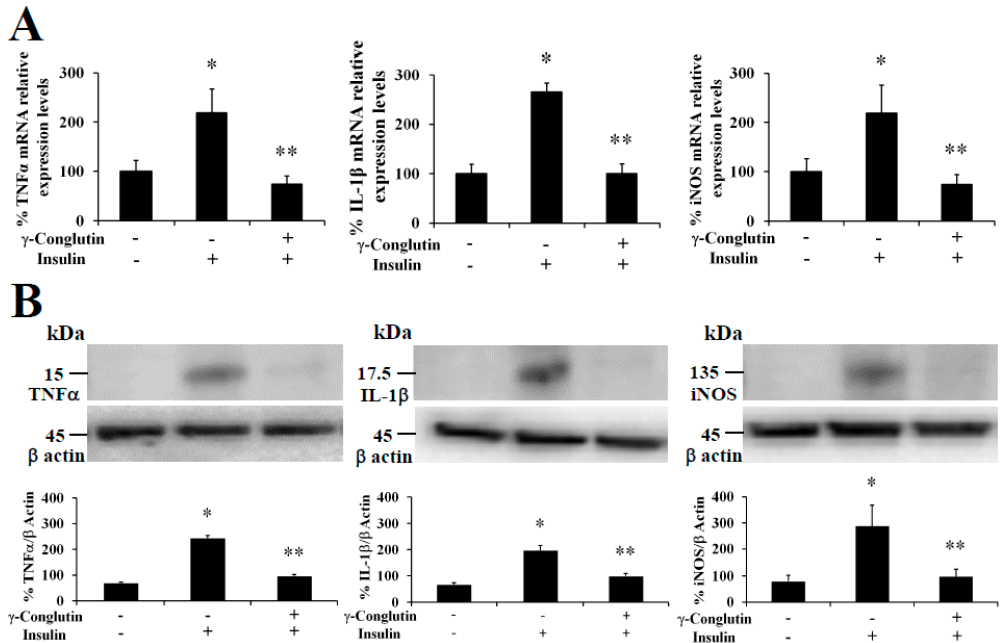
Figure 3. NLL γ -conglutin decreases the mRNA expression and protein levels of TNF α , IL-1 β and iNOS on an insulin-resistance IR-C cell model. Control PANC-1 cells, and IR-C pancreatic cells were cultured for 24 h alone, or the former culture with γ -conglutin. ( A ) The bar graph shows mRNA levels determined by real-time RT-qPCR of TNF α , iNOS and IL1 β . (B) The bar graph shows protein levels determined by immunoblotting of TNF α , iNOS and IL1 β . Average value from triplicate experiments of each biomarker were relativized to the average value of their housekeeping actin protein in control samples. Then, average values from challenge experiments (calculated in the same way than controls) are relativized to these from their respective control values previously calculated. Data represent mean ± SD from three independent experiments. Control: Untreated control PANC-1 culture cells; IR-C: insulin resistant culture cells; IR-C + γ : IR-C + γ -conglutin challenge. p < 0.05 represents statistically significant differences associated with each figure. p * < 0.05 IR-C versus control PANC-1 cells; p ** < 0.05 IR-C + γ -conglutin versus IR-C. Challenges were made with 25 μ g of γ -conglutin.